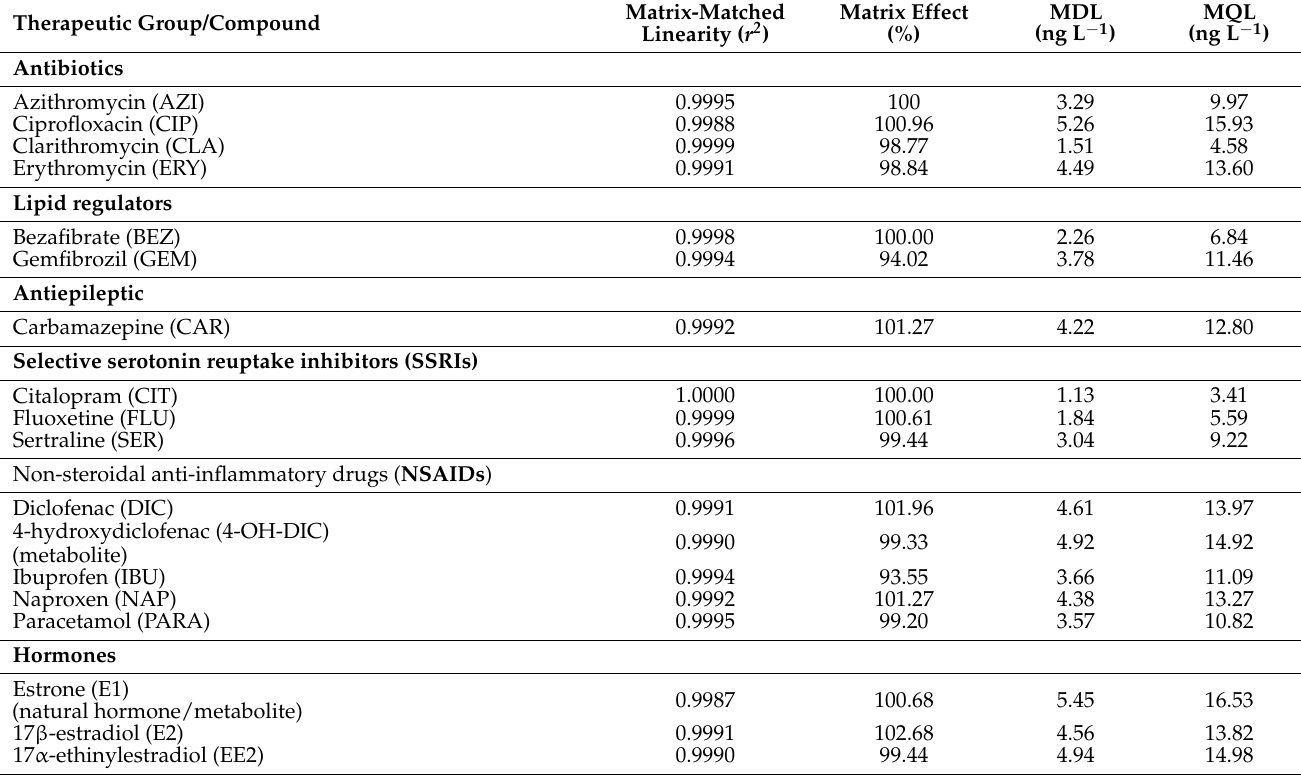
Table 1. Matrix-matched linearity, matrix effect, method detection limits (MDLs), method quantification limits (MQLs) of the selected